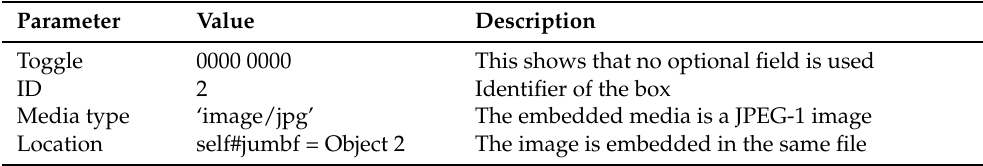
Table A4. Values of the second OBMB parameters for the first